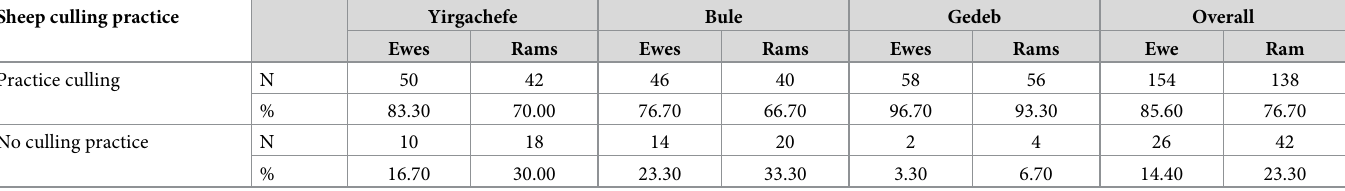
Table 10. Farmers’ sheep culling practice.